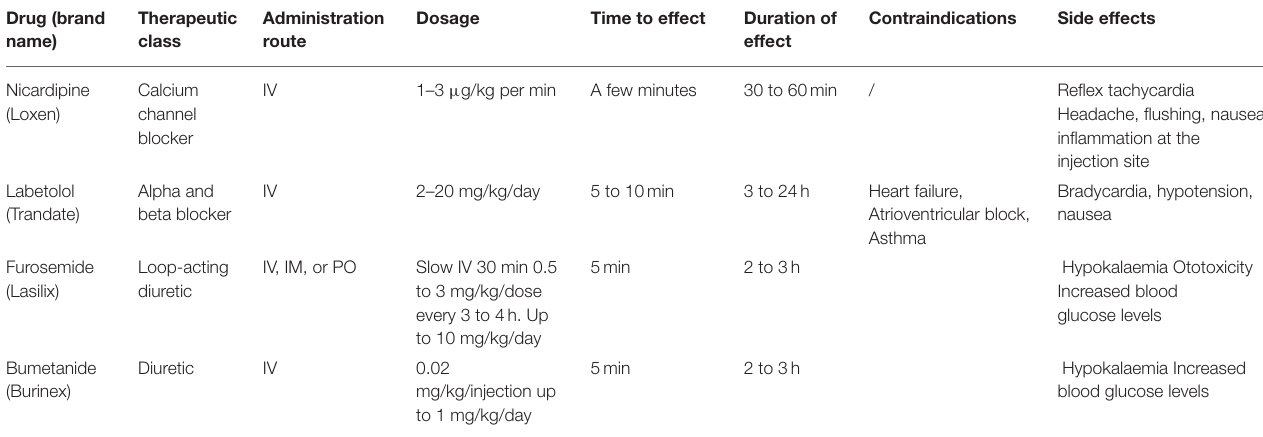
TABLE 6 | Management of hypertensive emergencies. Drug (brand